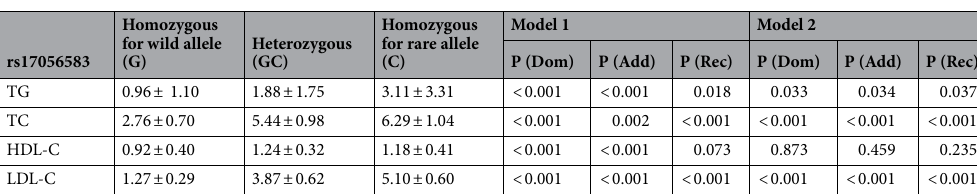
Table 3. Associations between rs17056583 and lipid parameters. TC total cholesterol; LDL-C low density lipoprotein-cholesterol; HDL-C high density lipoprotein-cholesterol; TG triglycerides; Dom dominant model; Rec recessive model; Add additive model; Model 1 unadjusted model; Model 2 analysis of covariance adjusted for sex, age, smoking, obesity, drinking, diabetes, hypertension and lipid profiles.